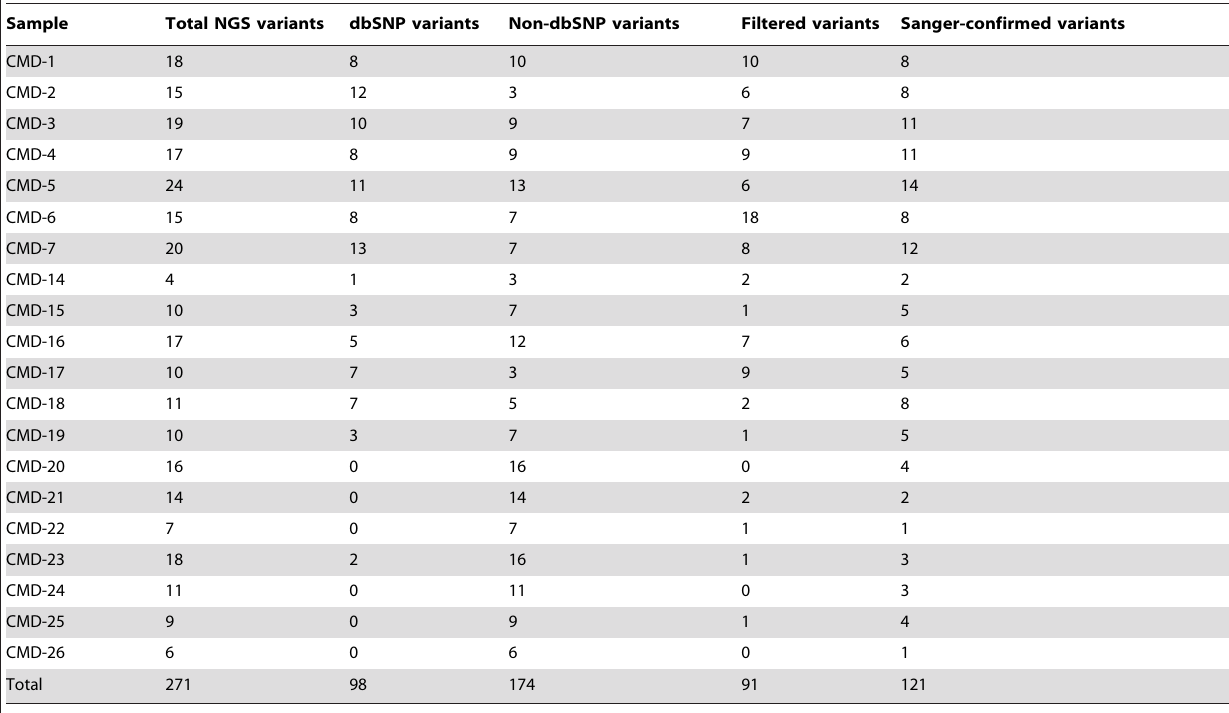
Table 6. Sequence variants identified by RainDance enrichment and NGS.